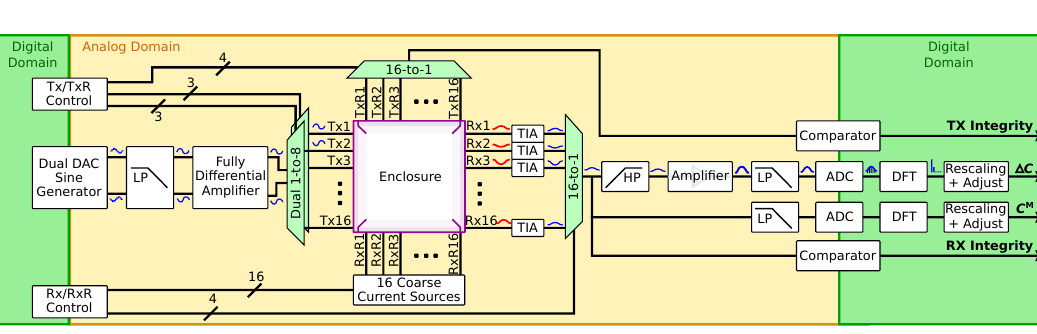
Figure 11: Block diagram of the entire measurement system for a 16 × 16 enclosure during differential capacitance measurement of the Tx1-2 group.